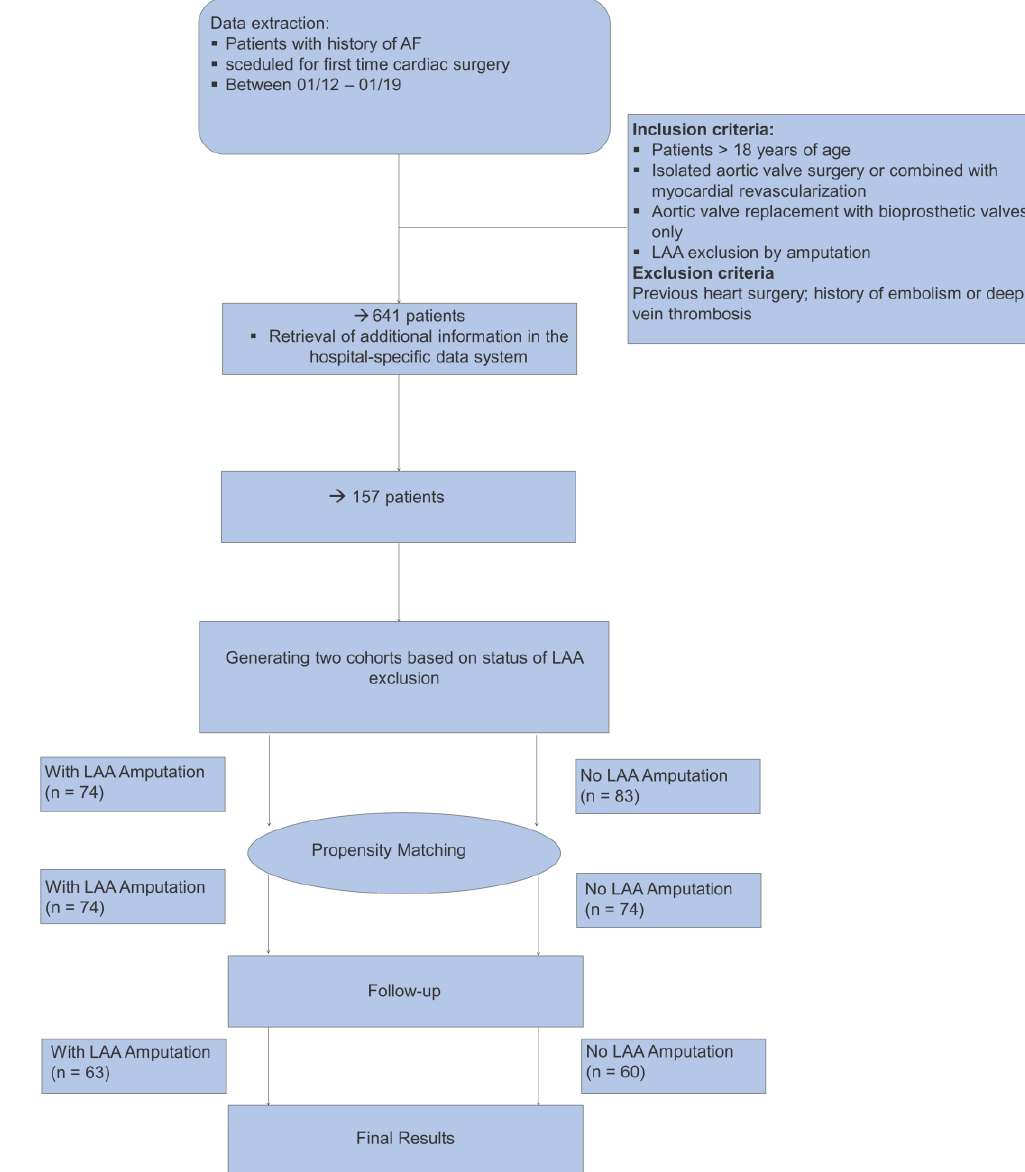
Figure 1. Flowchart displaying the patient data and activity flow.